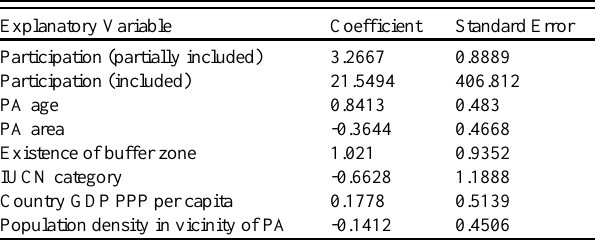
Table 5. Non-significant coefficients for the saturated model Explanatory